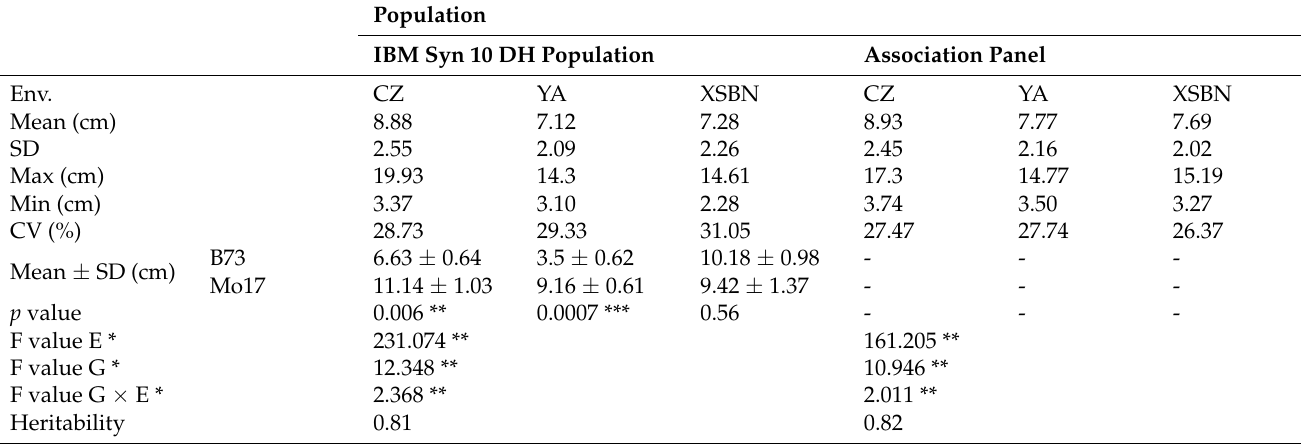
Table 1. Phenotypic description and analysis of variance for ESL in two populations under three